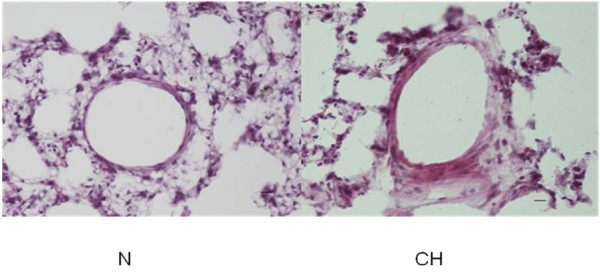
H&E-stained sections of small pulmonary arteries from the lungs of control rats (N) and rats exposed to hypobaric hypoxia for 21 days (CH). The results show representative sections from at least three rats per group for each time point. Scale bar = 10 μm.